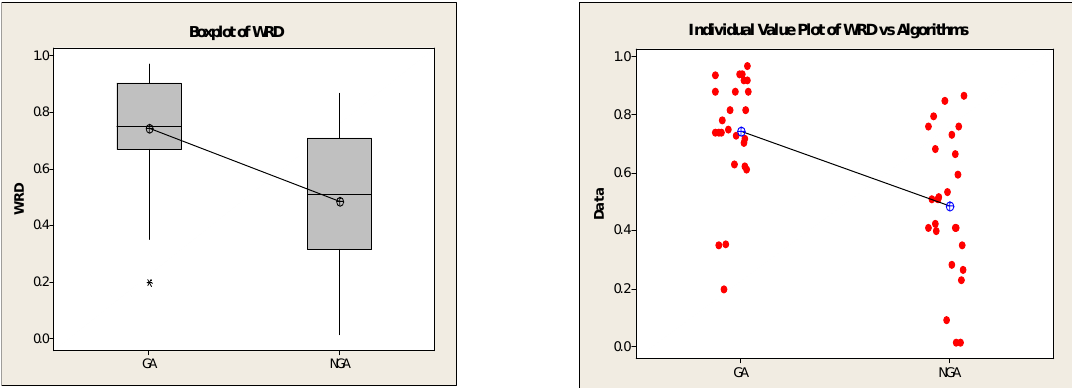
Fig. 3. Means plot and LSD intervals for the NGA and